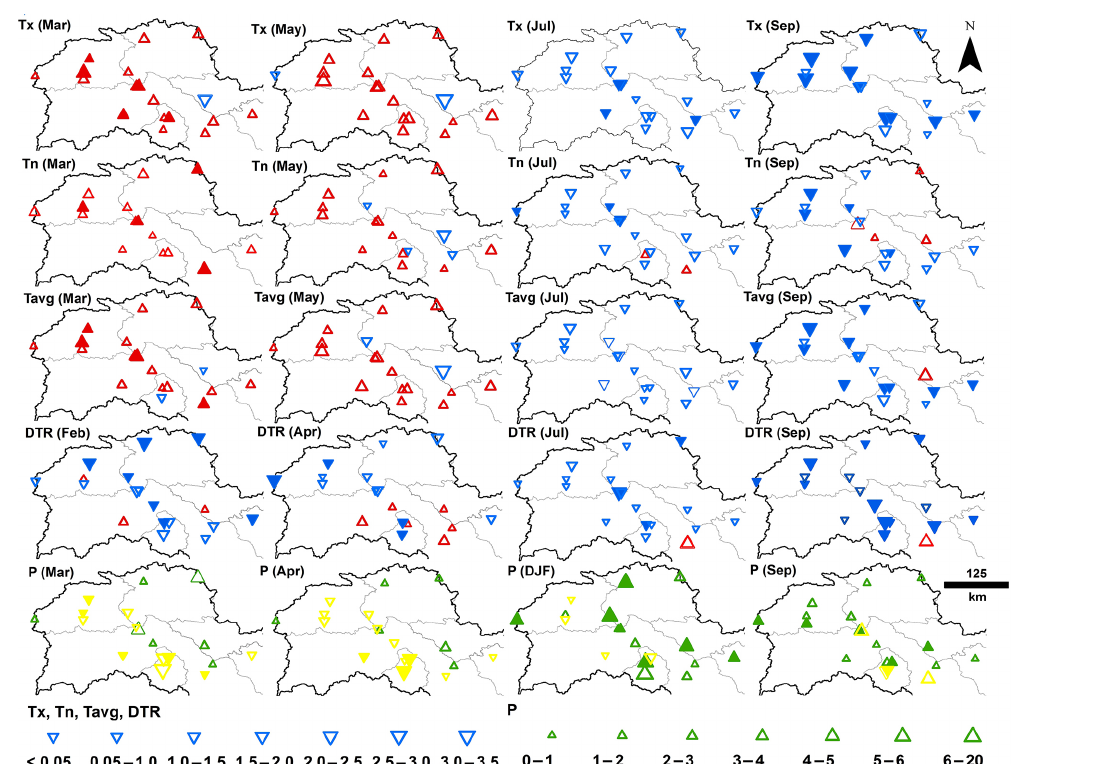
Figure 4. Trends per decade in T x , T n , T avg , DTR ( ◦ C) and trends per time step in P (mm) for select months and seasons. Triangles pointing upward (downward) or in green/red (blue/yellow) show increasing (decreasing) trends. Solid (hollow) triangles indicate significant (insignificant) trends at the 90%